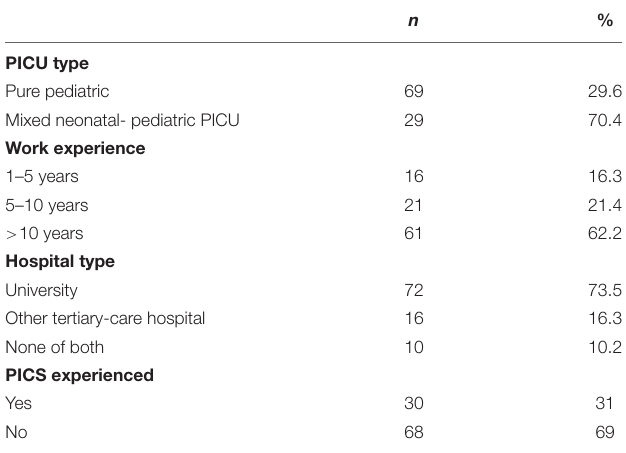
TABLE 1 | Responder characteristics ( N = 98).